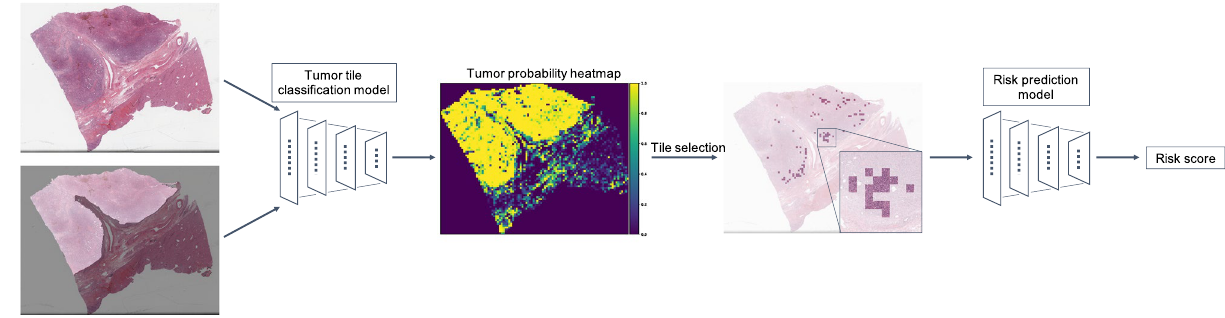
Figure 1. Overview of HCC-SurvNet. All WSI were preprocessed by discarding non tissue-containing white background using thresholding, then partitioned into non-overlapping tiles of size 299 × 299 pixels and color normalized. A tumor tile classification model was developed using the Stanford-HCCDET dataset, which contained WSI with all tumor regions manually annotated. The tumor tile classification model was subsequently applied to each tissue-containing image tile in the TCGA-HCC (n = 360 WSI) and Stanford-HCC (n = 198 WSI) datasets for inference. The 100 tiles with the highest predicted probabilities of being tumor tiles were input into the downstream risk prediction model to yield tile-based risk scores, which were averaged to generate a WSI-level risk score for recurrence. WSI, whole-slide